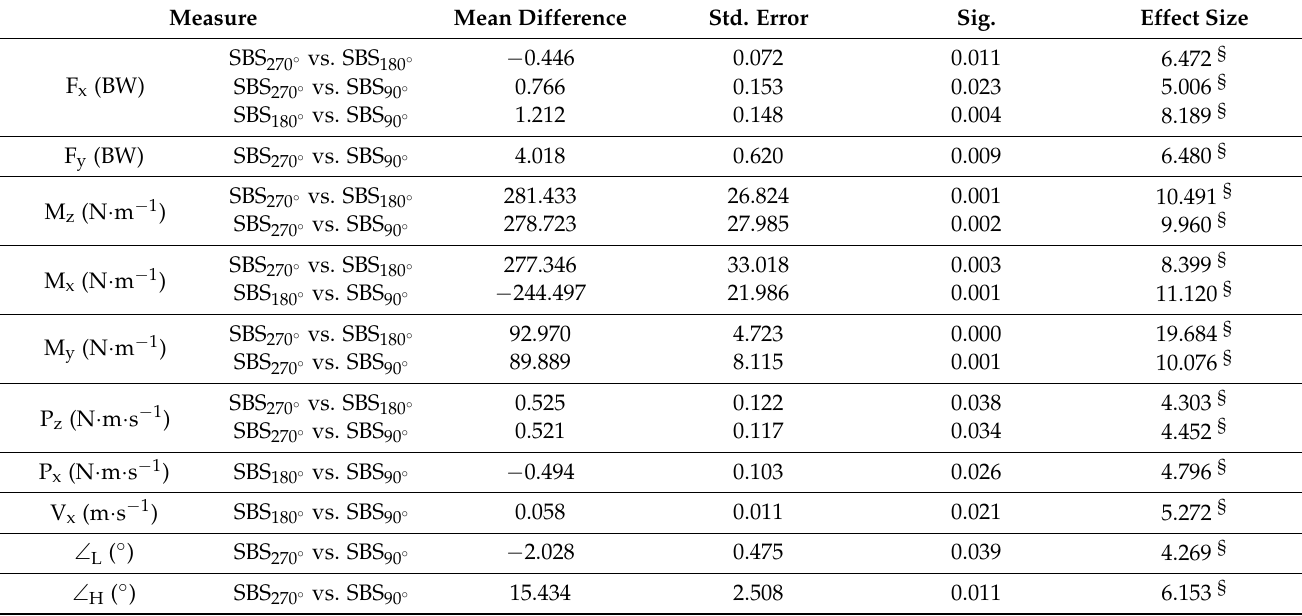
Table 3. Pairwise comparisons Bonferroni